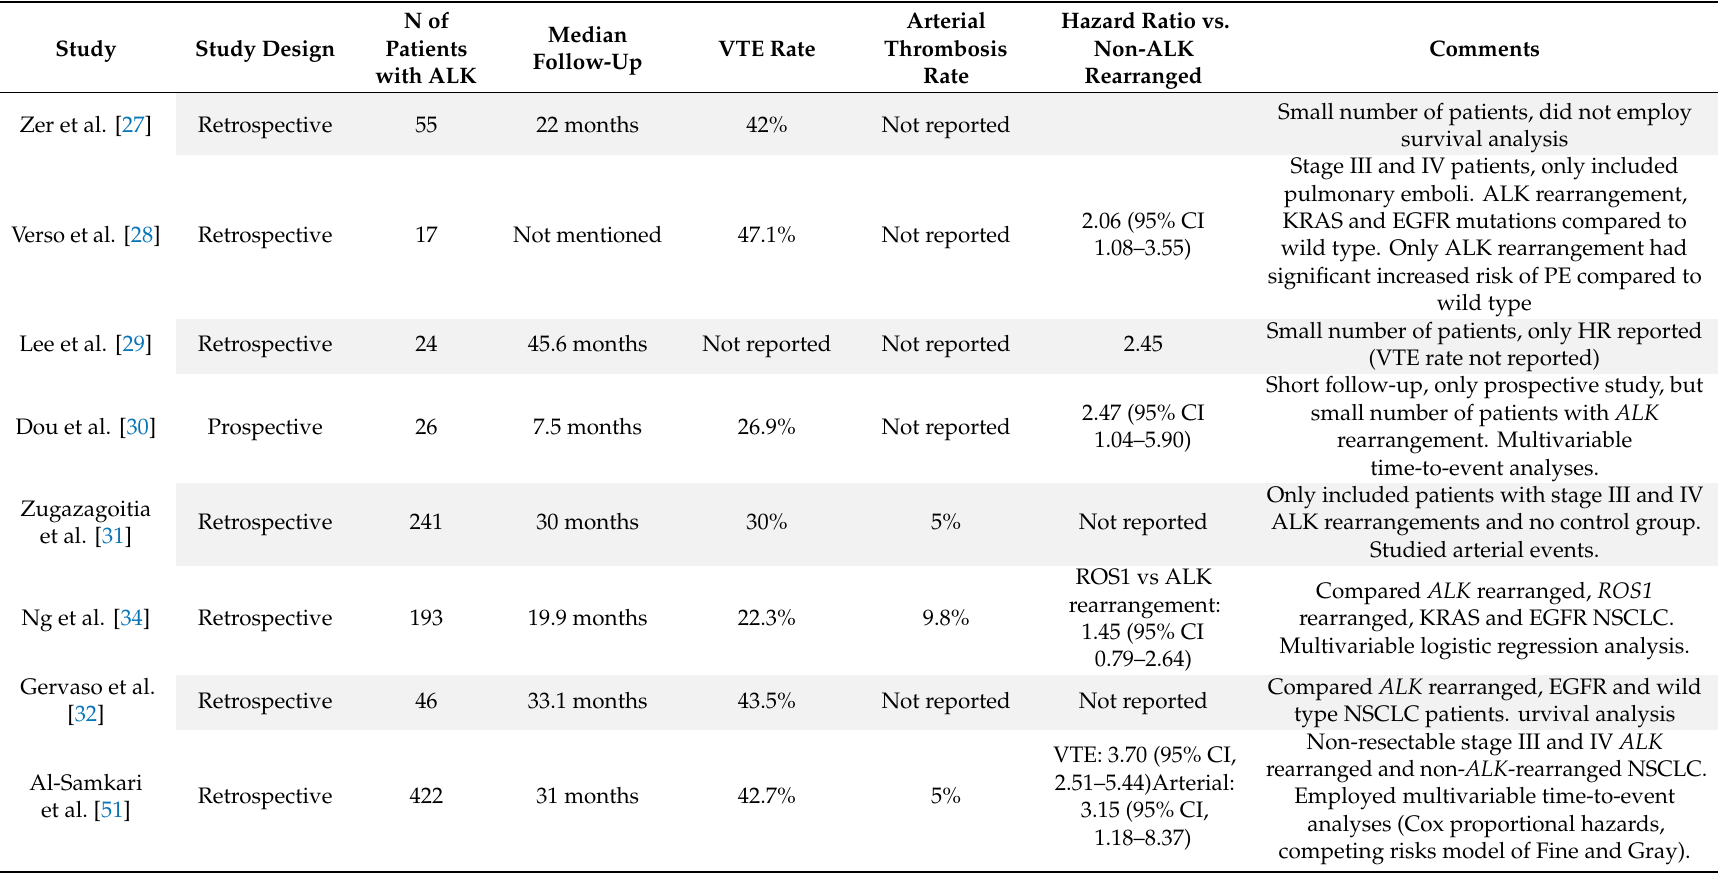
Table 3. ALK Rearrangement in Non-Small Cell Lung Cancer (NSCLC) is Associated with Increased Thrombotic